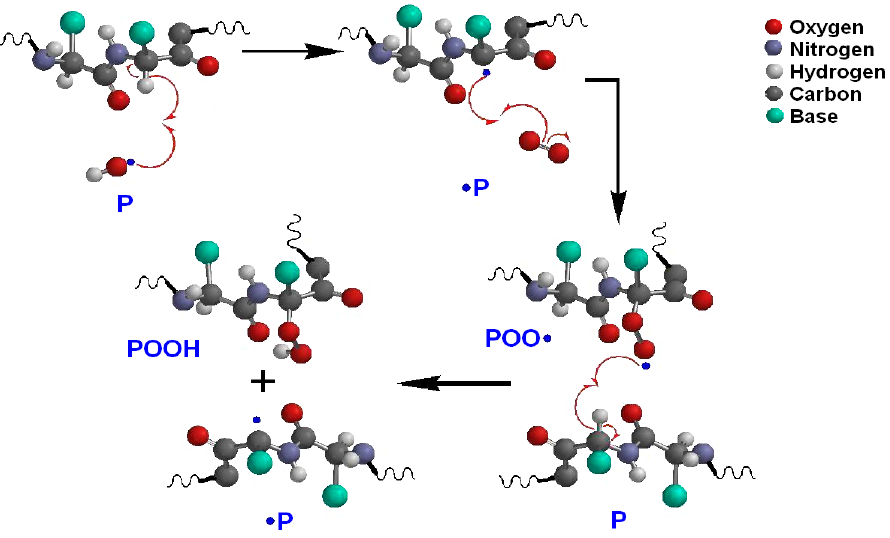
Figure 2. Lipid crosslinking mechanism from the reaction of two lipid radicals.